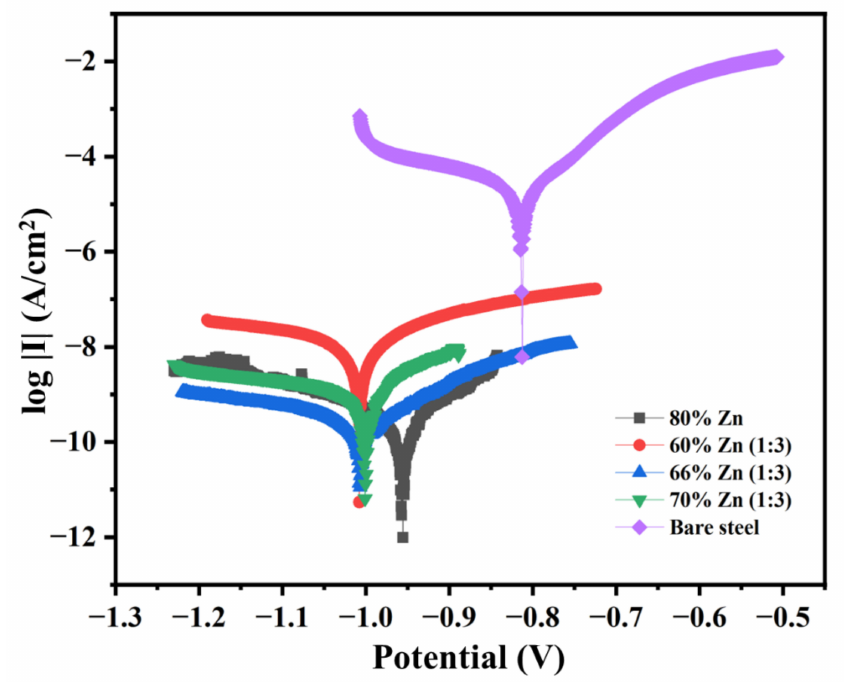
Figure 12. Polarization curves of ZRP coatings and bare steel